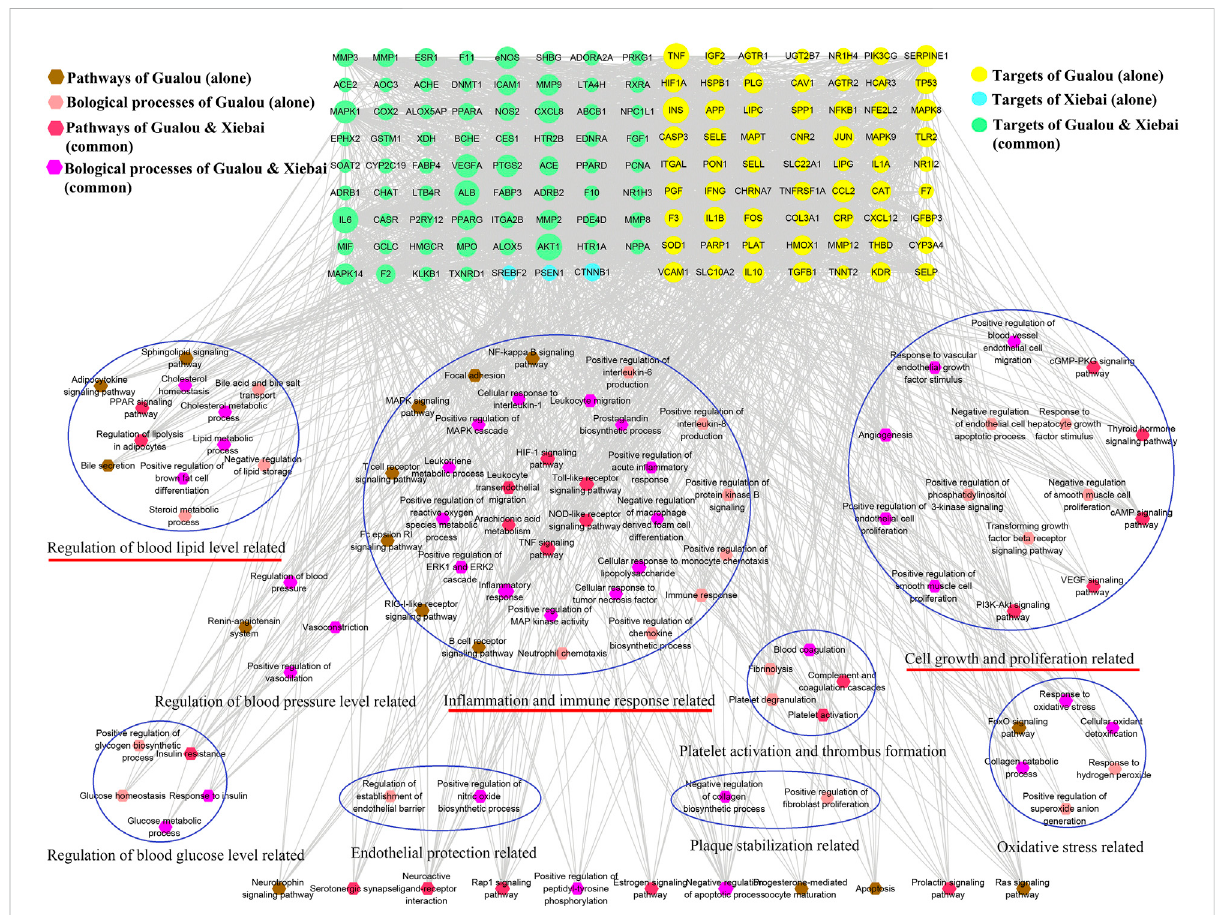
FIGURE 6 Target-pathway/biological process network of GLXB. Pathways of Gualou: labeled as brown hexagon nodes; biological process of Gualou: labeled as pink hexagon nodes; pathways of Xiebai: labeled as red hexagon nodes; biological process of Xiebai: labeled as purple hexagon nodes; targets of Gualou: labeled as yellow circle nodes; targets of Xiebai: labeled as blue circle nodes; targets of Gualou and Xiebai: labeled as green circle